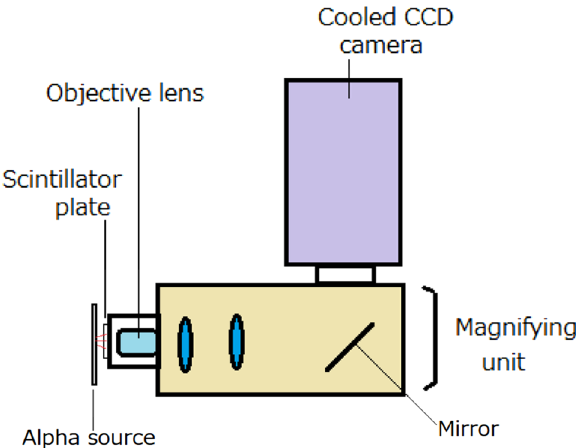
Figure 1. Schematic drawing of developed high-resolution alpha-particle imaging